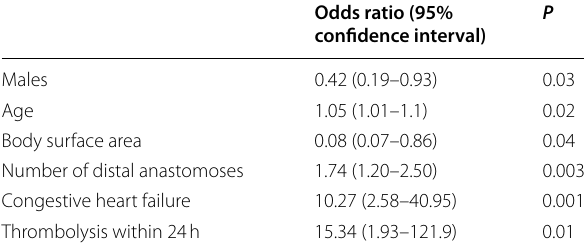
Area under the curve